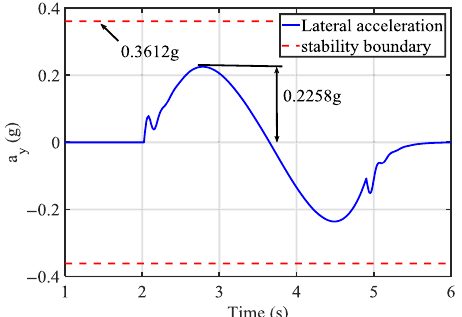
Figure 16 The longitudinal acceleration